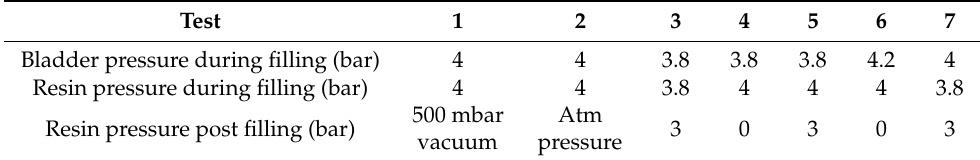
Table 3. Test Plan for optimizing B-RTM parameters for a tubular